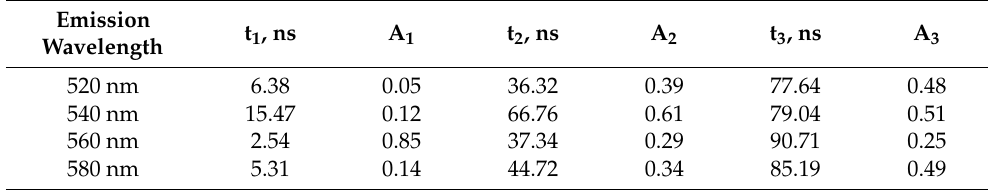
Table 5. Parameters of three exponential approximations of the decay curves presented in Figure